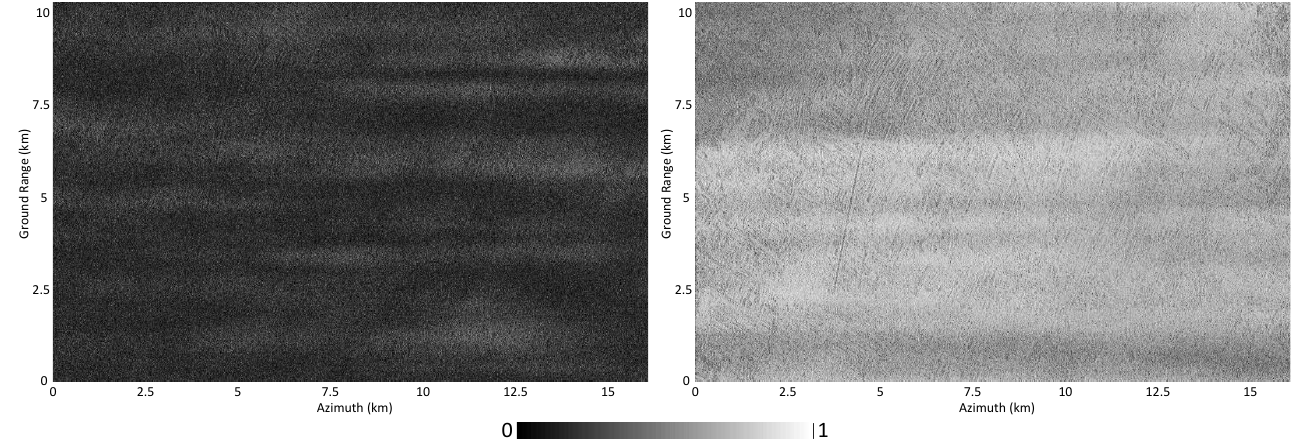
Figure 11. The correlation coefficients of the influenced ( left ) and corrected ( right ) images with the original image.